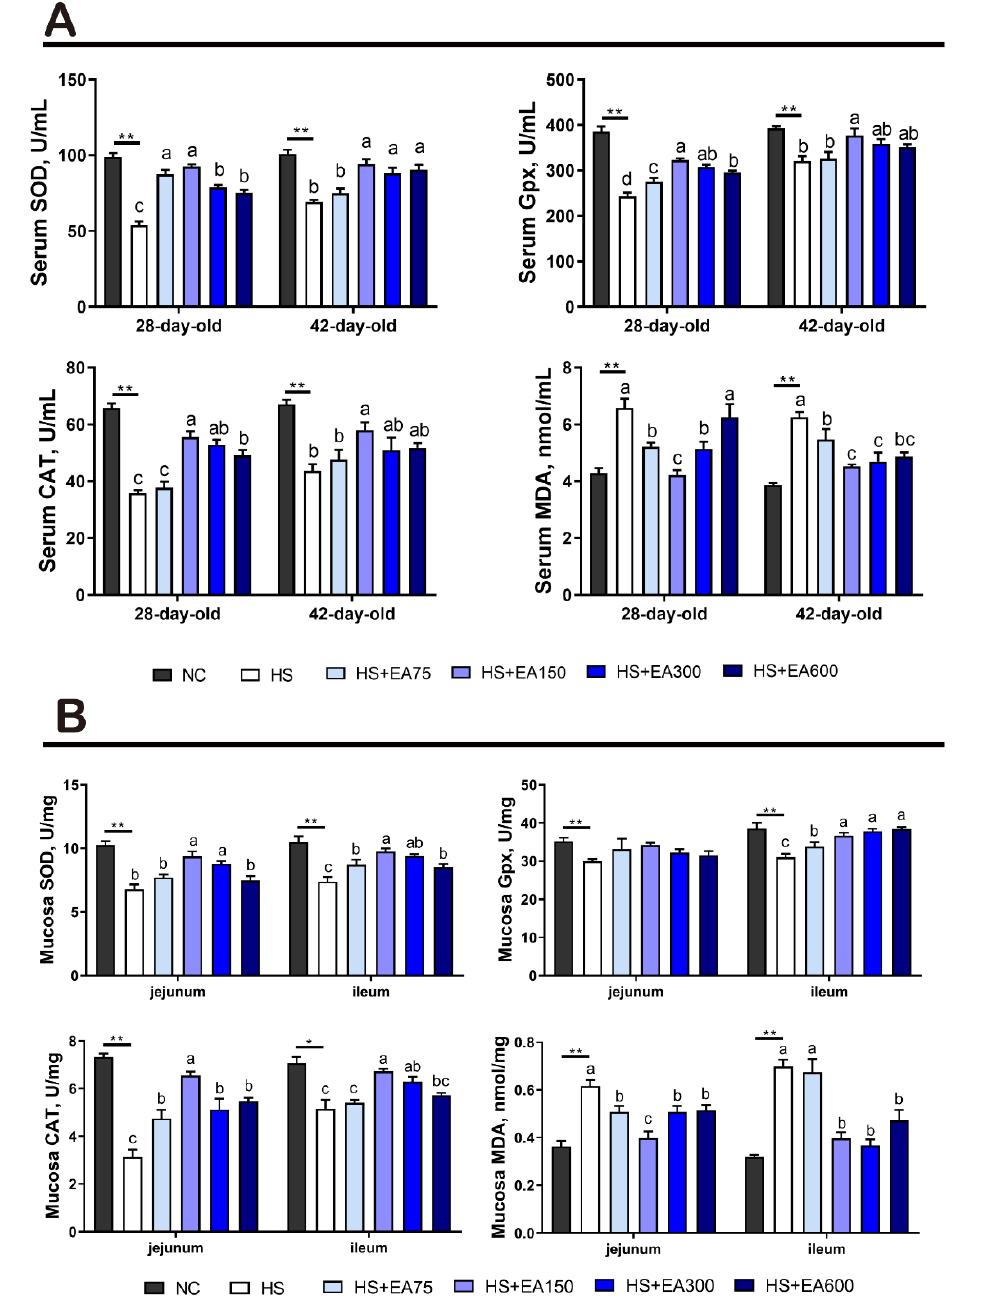
Figure 6. Effects of dietary EA on serum and mucosa antioxidant enzyme activities of the heat- stressed broilers. ( A ) Serum antioxidant enzyme activity; ( B ) antioxidant enzyme activity of the jejunal and ileal mucosa. SOD, superoxide dismutase. GSH-px, glutathione peroxidase. CAT, catalase. MDA, malondialdehyde. Data are presented as mean ± SEM (n = 6). NC (negative control) represents the broilers supplemented with a basal diet at normal temperature (23±2 °C). The broilers in the 5 experimental groups were supplemented with basal diets containing different levels of EA (0, 75, 150, 300, and 600 mg/kg) at HS temperature (35±2 °C), which are represented as HS, HS + EA75, HS + EA150, HS + EA300, and HS + EA600, respectively. Shared superscript letters indicate no signifi- cant difference ( p > 0.05). “*” indicates a significant difference between groups where p < 0.05. “**” indicates a significant difference between groups where p < 0.01.